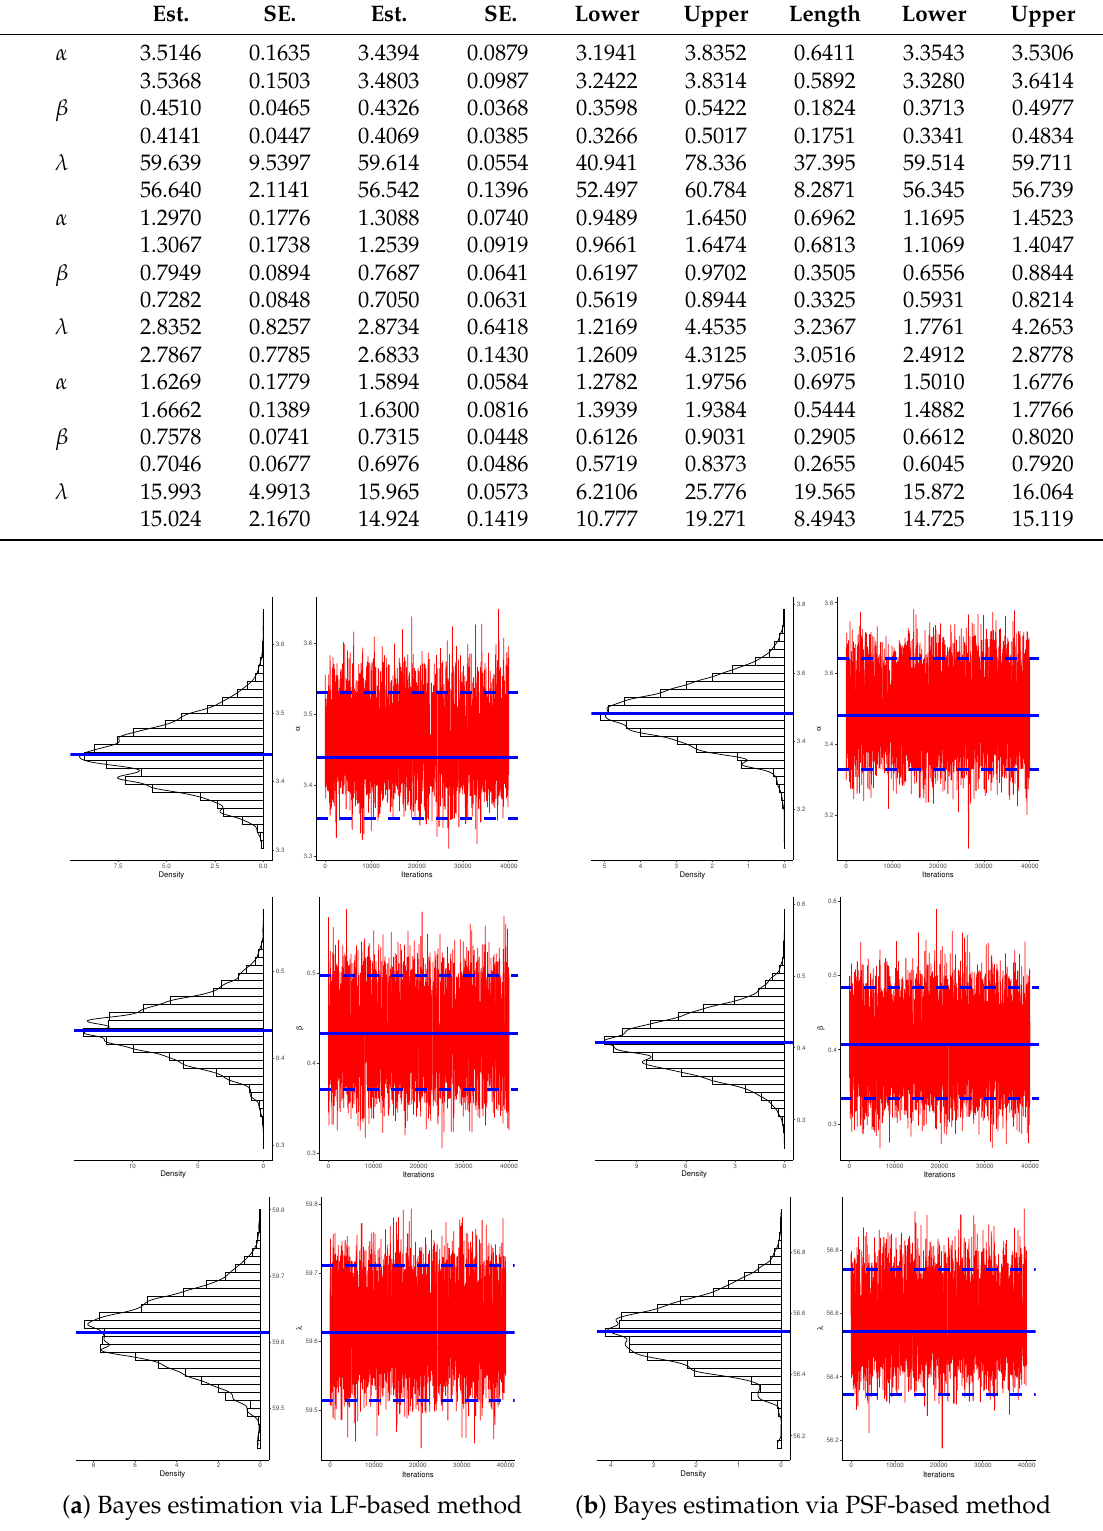
Figure 13. Density ( left ) and trace ( right ) plots of α , β , and λ from LED